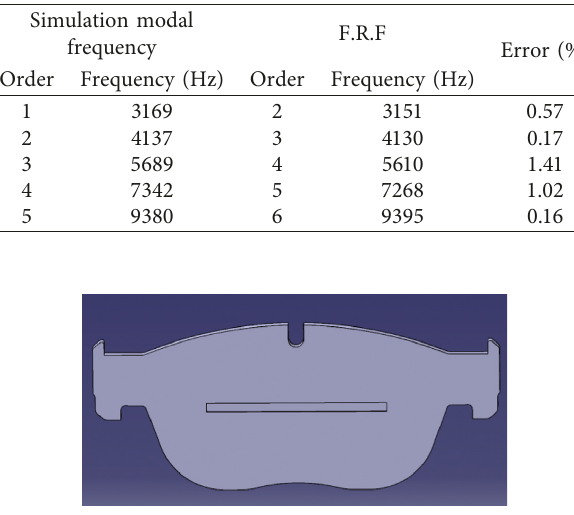
Figure 6: Sample 1 (single horizontal slot).